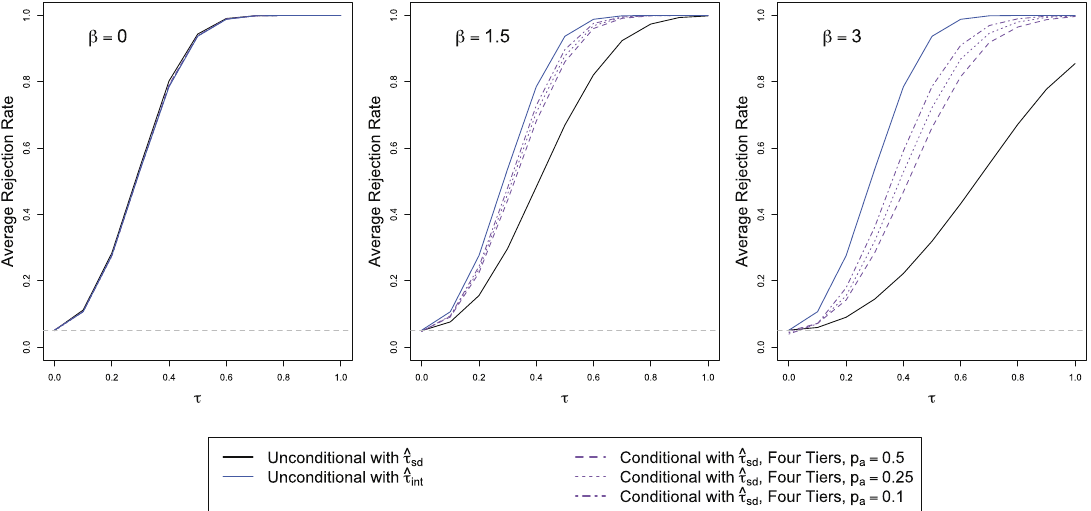
Figure 1: Average rejection rate (power) of Fisher’s Sharp Null for the unconditional randomization test using ̂ τ sd and ̂ τ int , as well as our conditional randomization test using ̂ τ sd